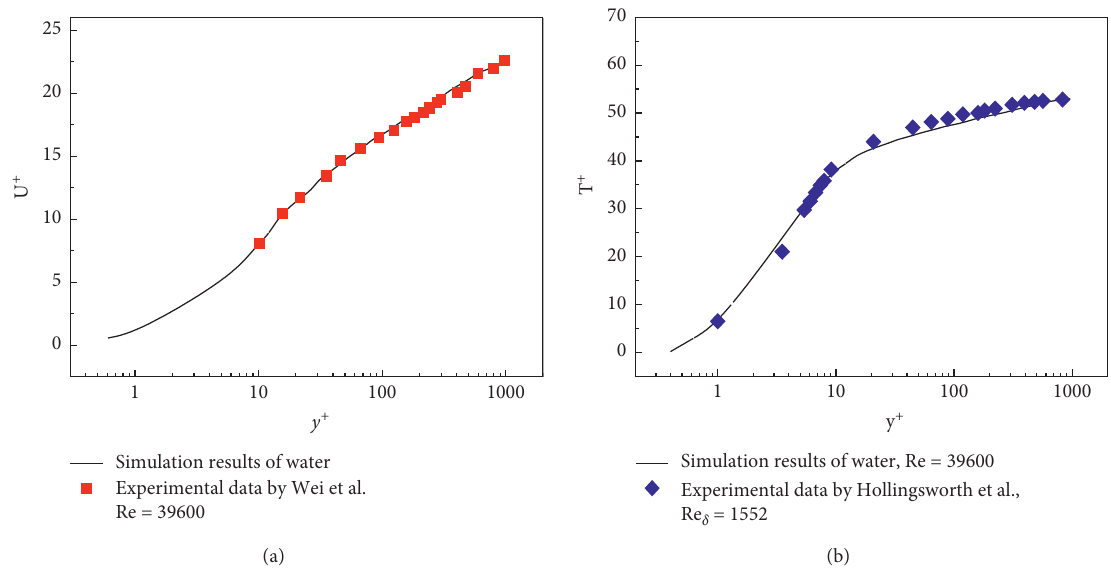
Figure 8: Comparison of water numerical simulations and experimental data. (a) Profile of water velocity and (b) profile of water